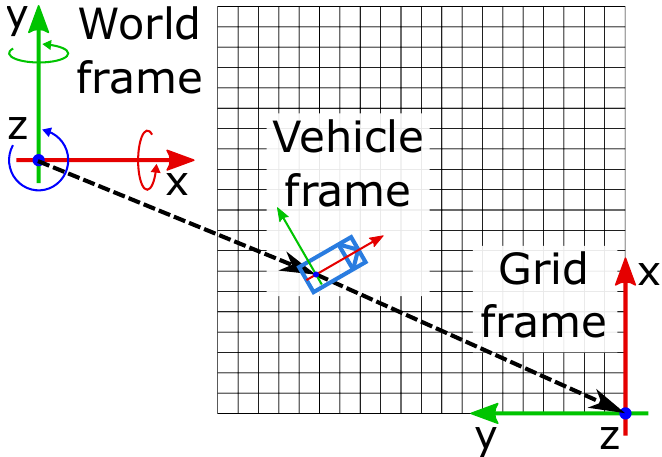
Figure 1. Coordinate systems used to position the occupancy grid in the world